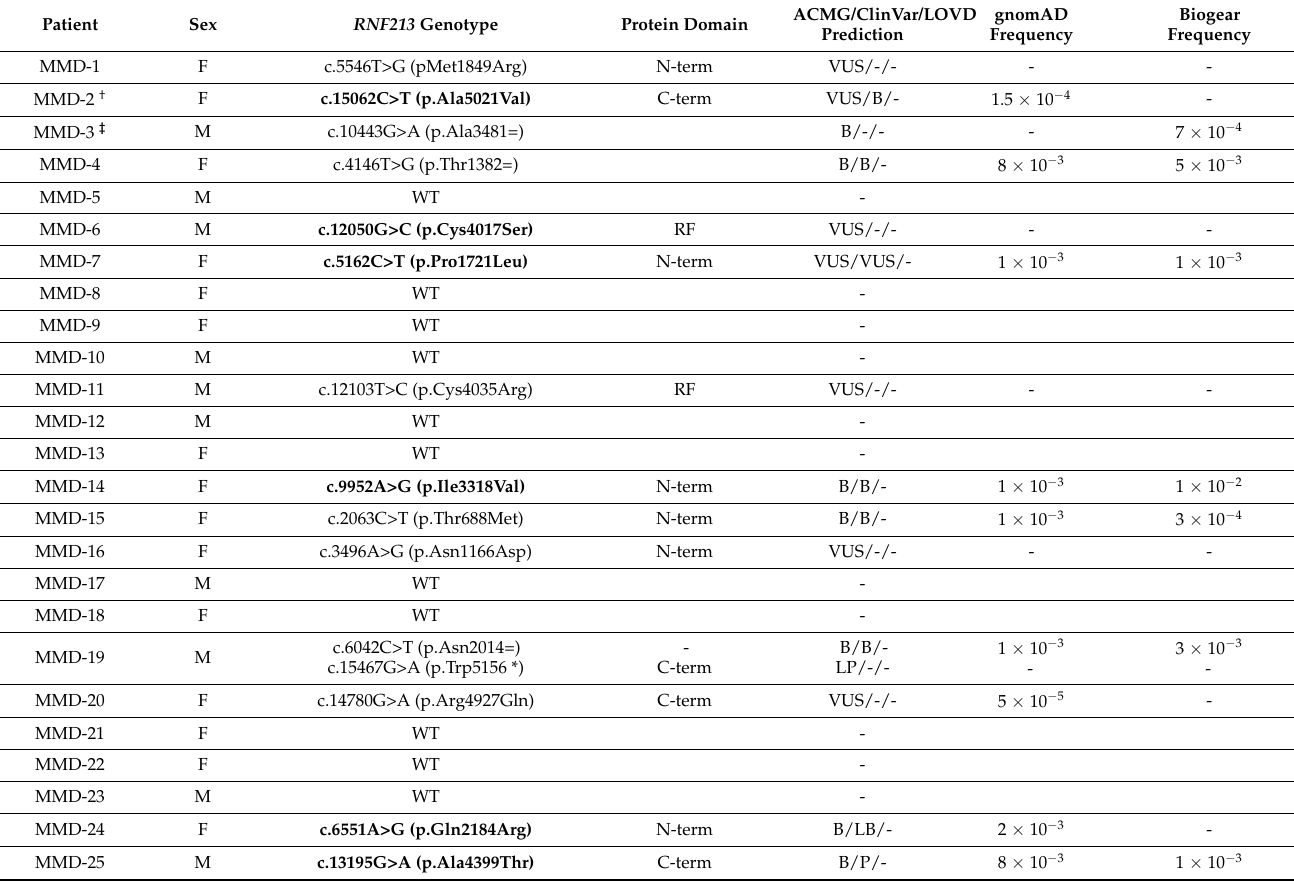
Table 4. RNF213 genotype of MMD